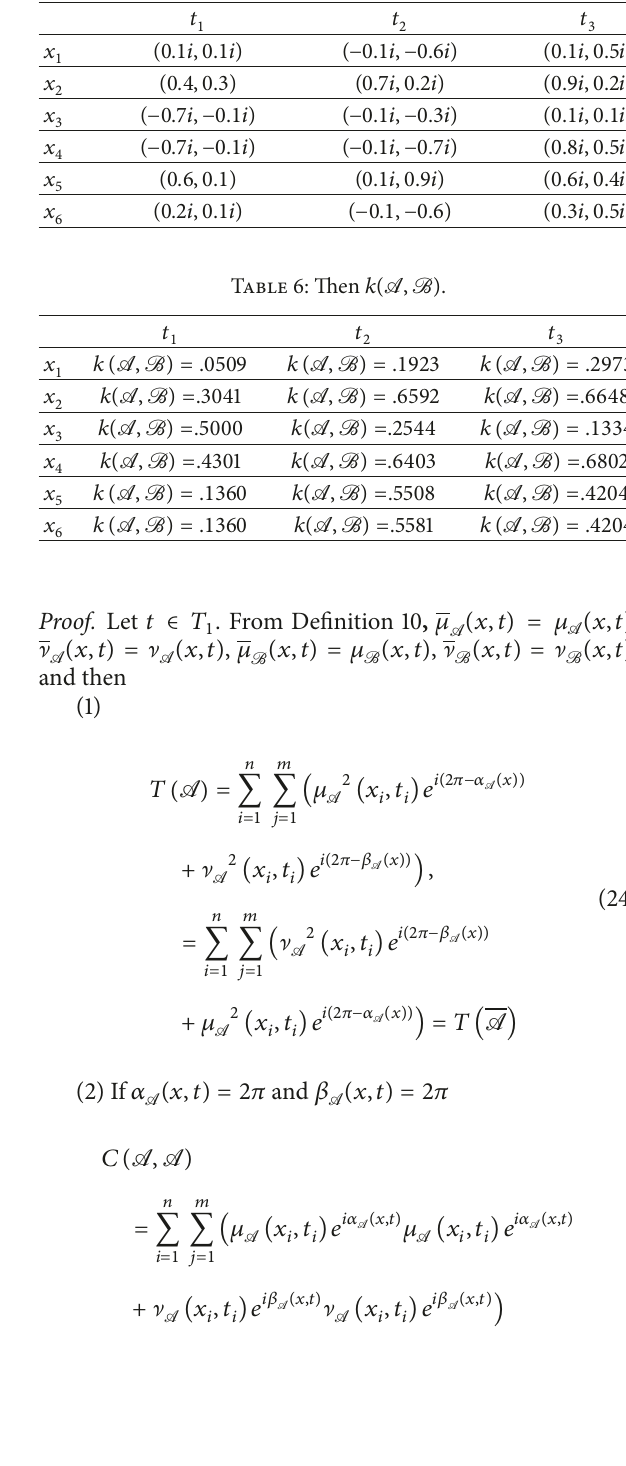
Table 5: TCIFS B (𝑇) .